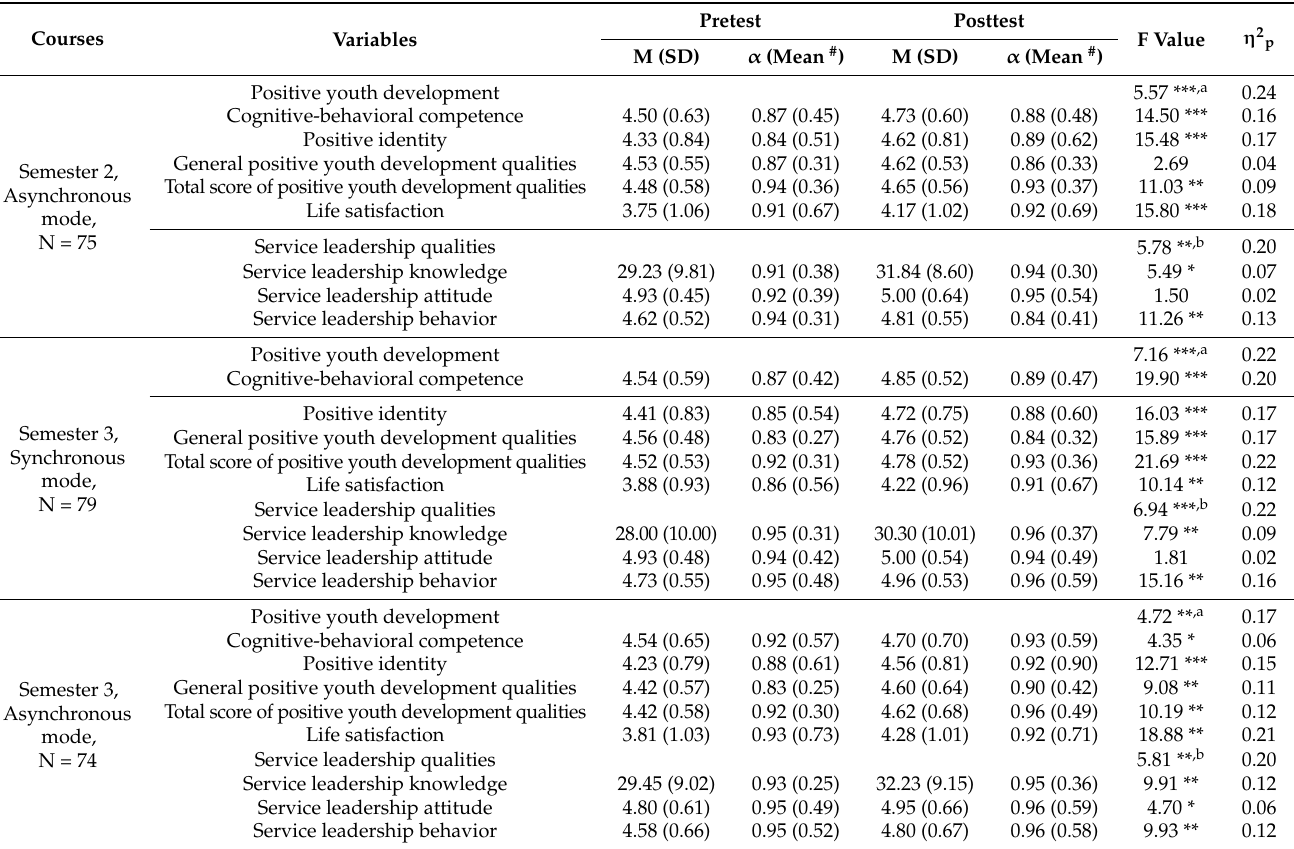
Table 2. Reliability and overall changes in different outcome indicators between the pretest and